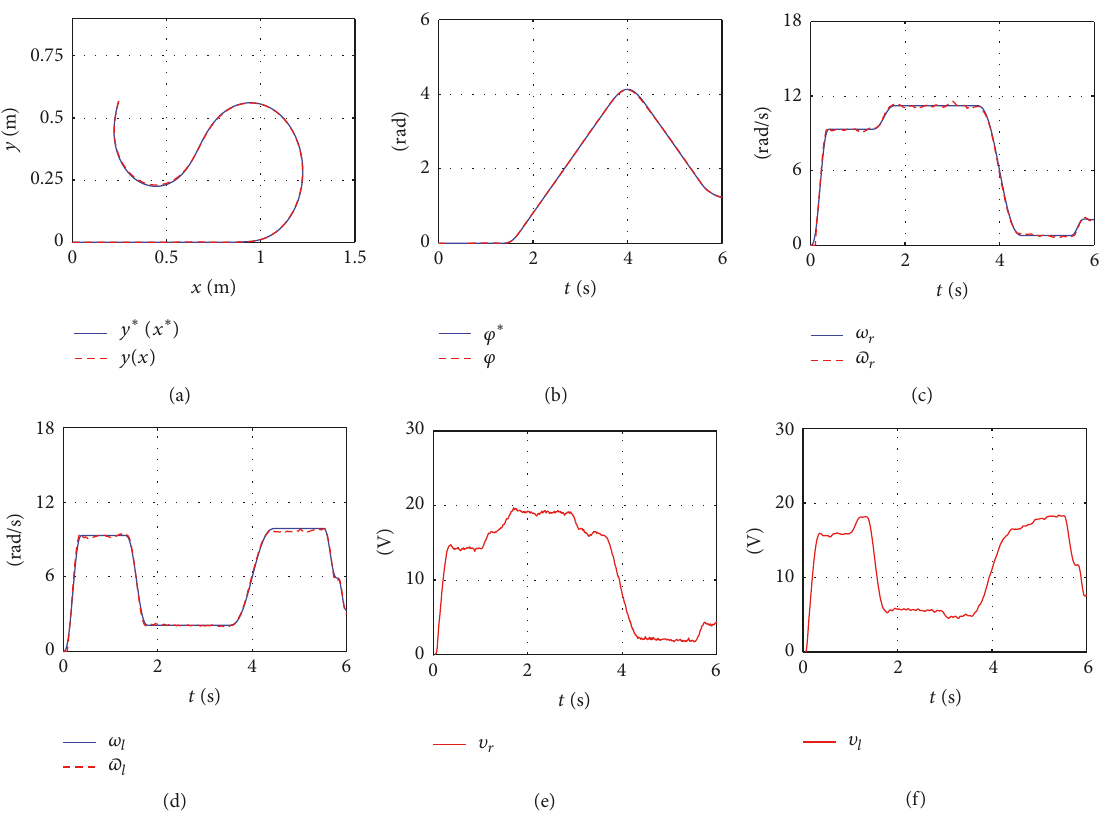
Figure 8: Control objective is not accomplished when abrupt changes in Table 3, that is, associated with 𝐸 , appear.